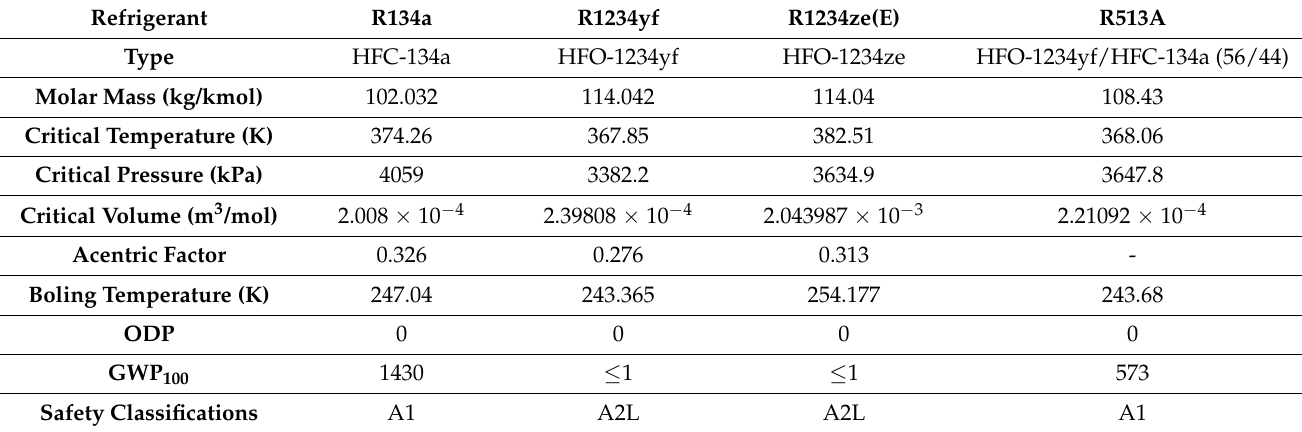
Table 2. Refrigerant properties [3–6].